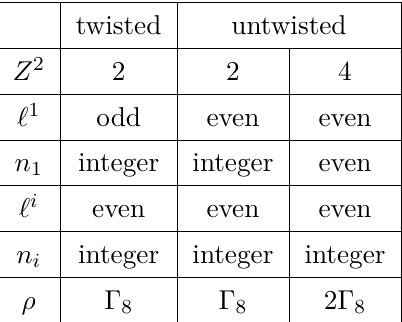
Table 4 . Quantum numbers of the massless states in the twisted and untwisted sector. The index i > 1 corresponds to further compactifications of the nine-dimensional theory. States with Z 2 = 4 can only be massless in D < 9 dimensions. The states must satisfy (3.7) to be